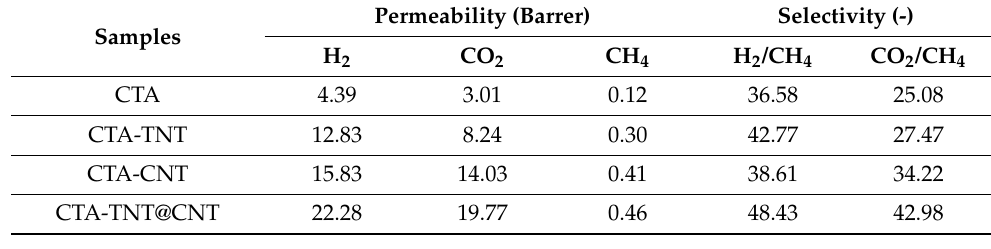
Table 2. Gas permeability and selectivity of the synthesized membranes.